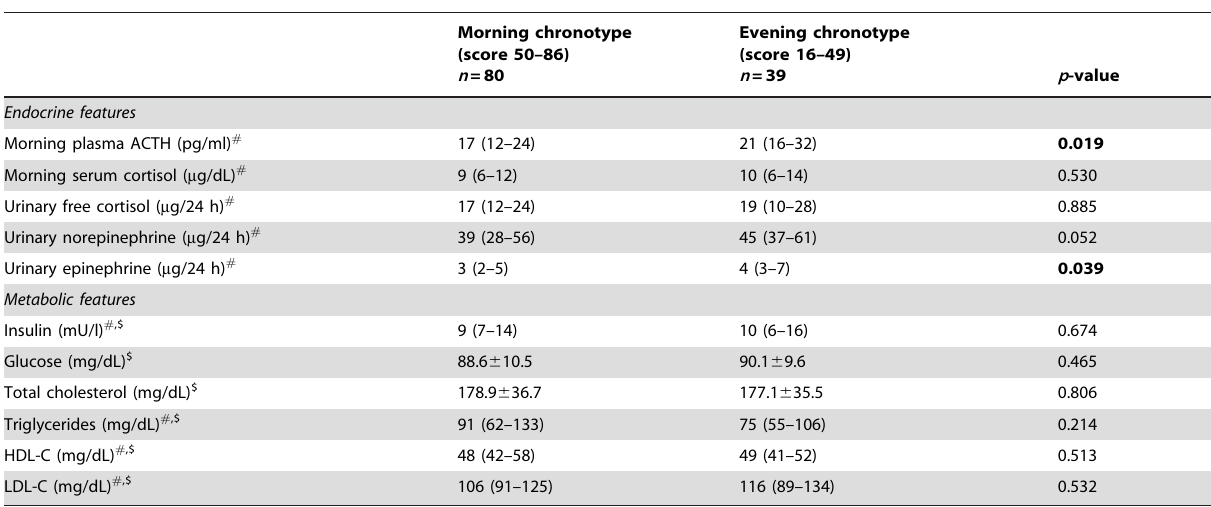
Table 4. Endocrine and metabolic parameters of study